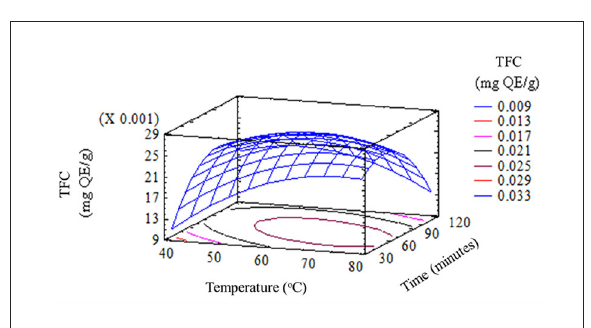
FIGURE2 Effect of extraction temperature and time on the TFC in garlic husk.